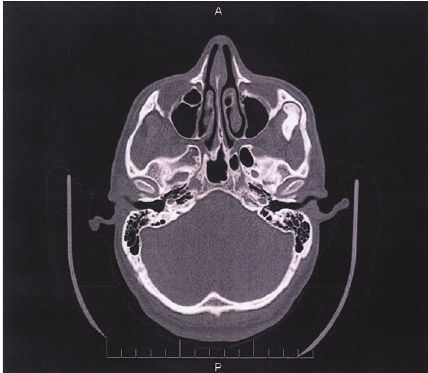
Figure 3: CT image of exophytic mass projecting from left coronoid process.